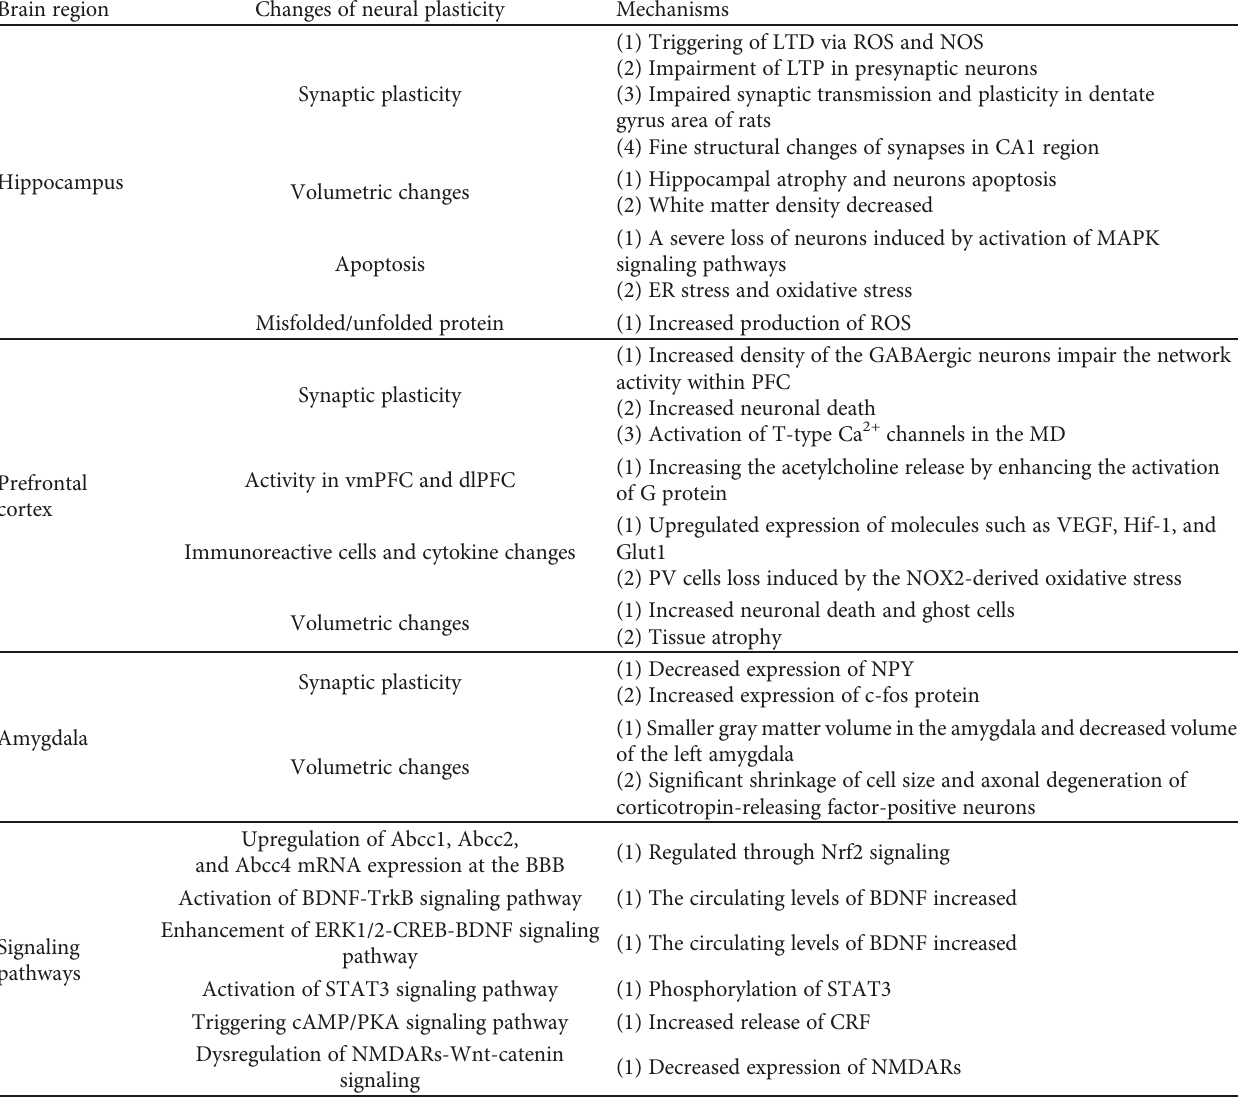
Table 1: Changes of neural plasticity induced by hypoxic-ischemic injury in various brain